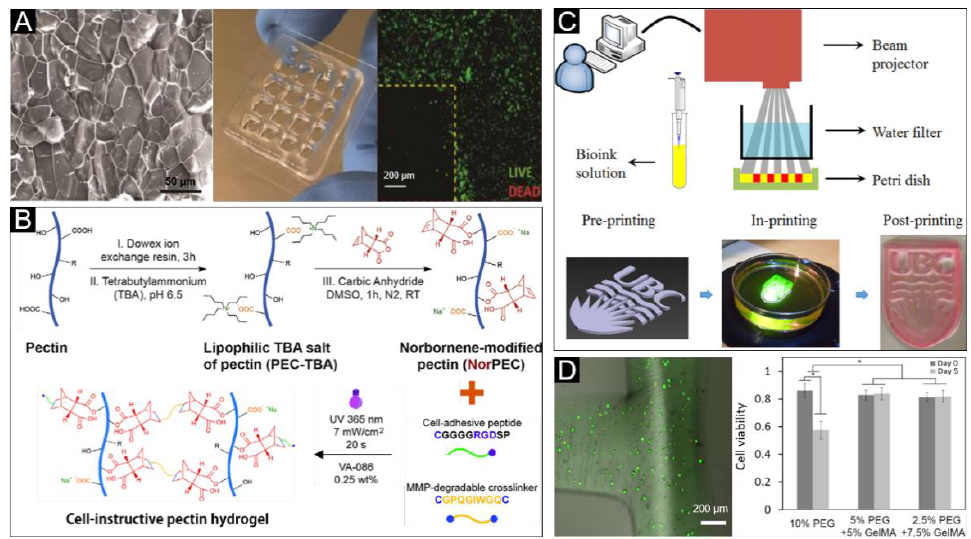
Figure 7. Photosensitive bioink for skin bioprinting. ( A ) Microstructure (left) and image (middle) of the pectin hydrogel with optimal crosslinker, and confocal microscopy image (right) of fibroblasts live/dead staining, which indicated high cell viability embedded within the 3D porous